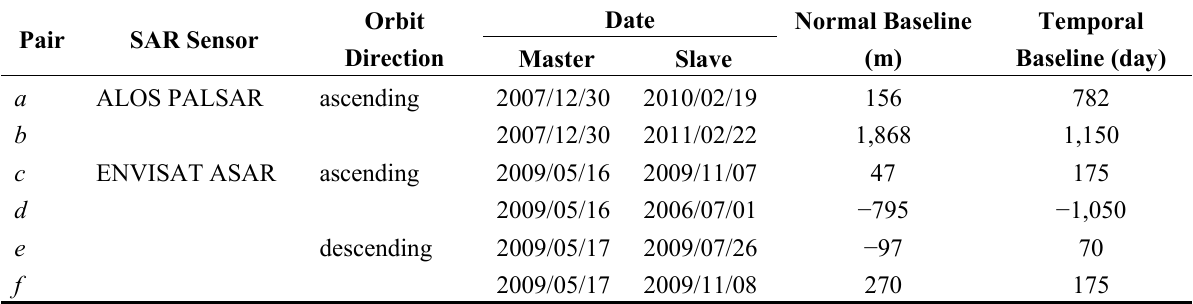
Table 1. The interferogram information for coherence